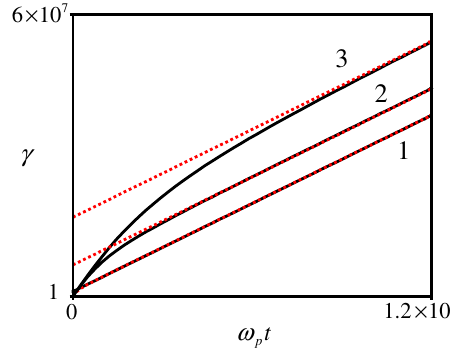
t in AAR: analytic solution FIG. 3. The dependence of (cid:6) on ! p (red dashed lines) and numerical solution (black solid line) for ¼ 0 : 8 (lines 1), R ¼ 0 : 2 (lines 2) and R ¼ 0 : 1 (lines R (cid:5); 0 (cid:5); 0 (cid:5); 0 3). The other parameters are the same as in Fig.